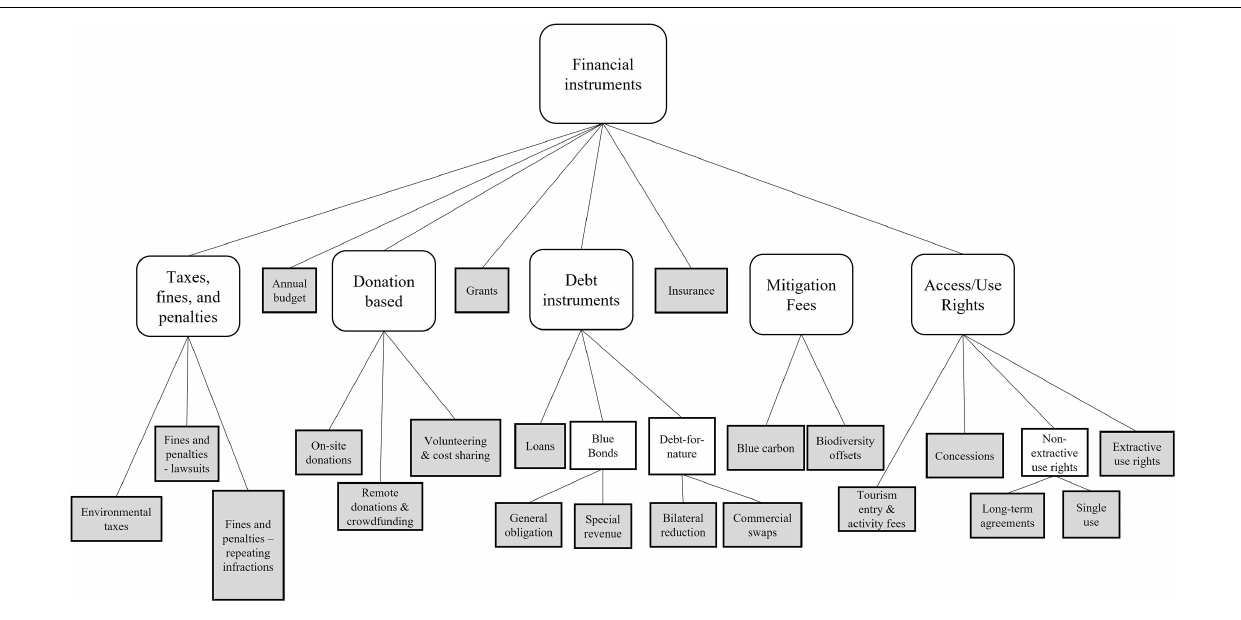
FIGURE 5 | Organizational chart of financial instruments compiled in the review. Instruments with individual sets of indicators are represented by shaded